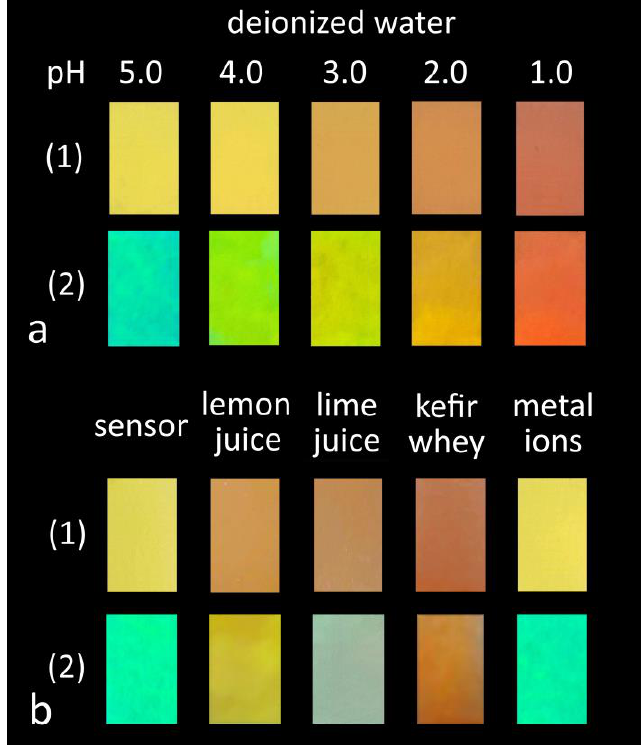
Figure 4. pH-induced color changes of paper test strips based on QC1 ( 1 ) in daylight and ( 2 ) under irradiation by LED ( λ = 365 nm) for ( a ) deionized water with different pH values and ( b ) for 3 real-life samples: lemon juice (pH = 2.45), lime juice (pH = 1.95), kefir whey (acidified to pH 1.20), and an aqueous solution with pH 4.52 and containing metal perchlorates (0.1 mM of 14 salts).